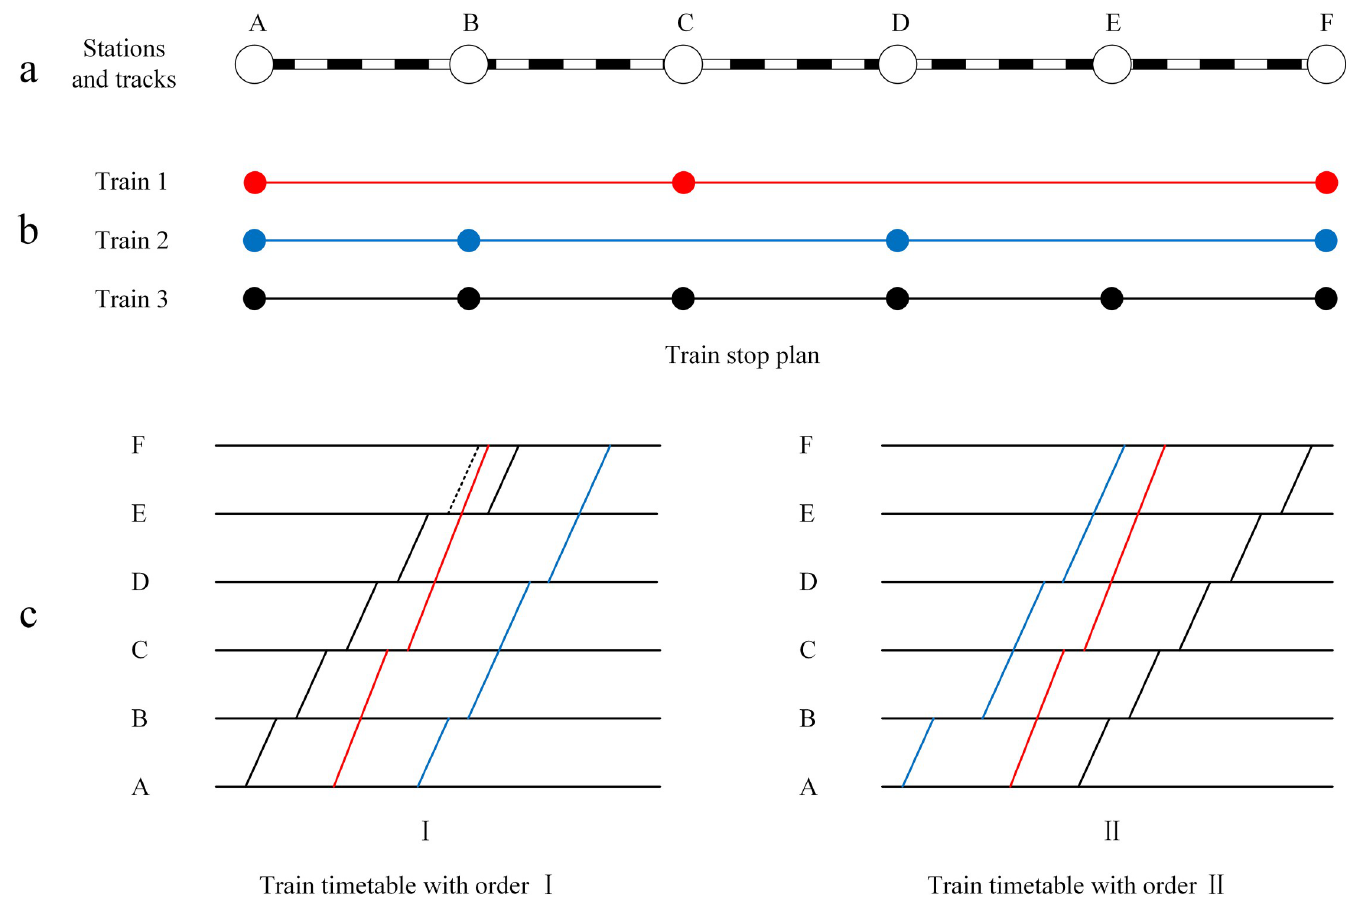
Fig 2. Three levels of the network in high-speed